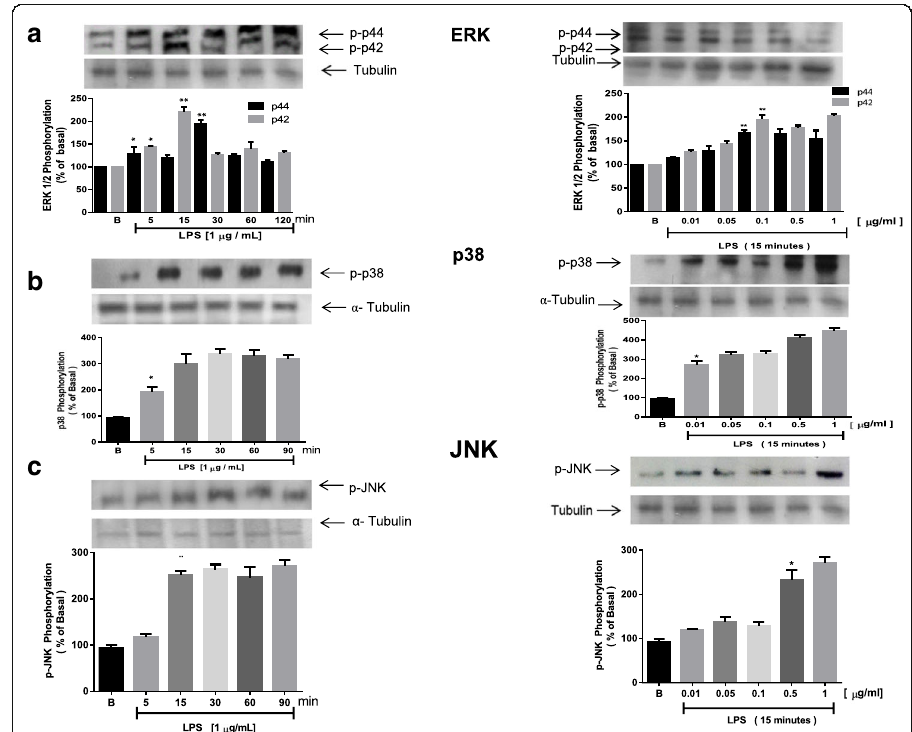
Fig. 3 Lipopolysaccharide stimulation induces phosphorylation of ERK 1/2, p38, JNK in cardiomyoblast. H9c2 cells were incubated with LPS (1 μ g/ml) for the indicated periods of time or with the indicated concentrations of LPS for 15 or 30 min. Cell lysates were separated by sodium dodecyl sulfate polyacrylamide gel electrophoresis (SDS-PAGE), transferred to a PVDF membrane, and immunoblotted with anti-phosphorylated-ERK 1/2 ( a ), − p38 ( b ) or -JNK antibodies ( c ). The membrane was then stripped and incubated with anti-tubulin antibodies. The data are representative of three independent experiments. The means ± SEM were obtained by densitometry. * p < 0.05 vs. untreated